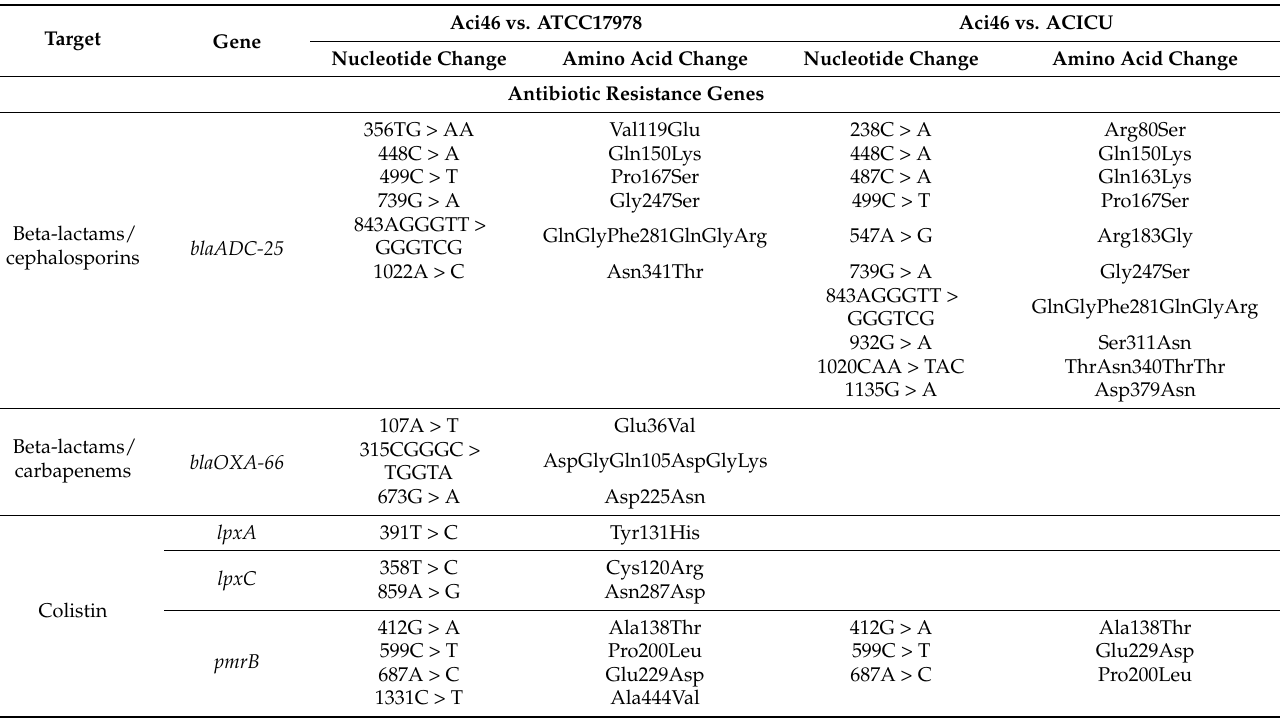
Figure 4. Comparisons of deduced amino acid sequences of blaOXA-66 from five strains of A. baumannii by multiple sequence alignment. Table 5. List of non-synonymous SNPs in antibiotic resistance genes and efflux pumps from core gene group.